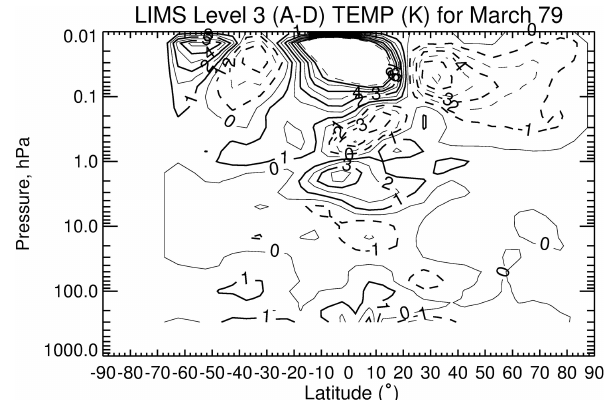
Figure 4. LIMS V6 level 3 ascending minus descending ( A − D ) temperature differences (in K) for March 1979. CI is 1K, and solid contours show positive differences.